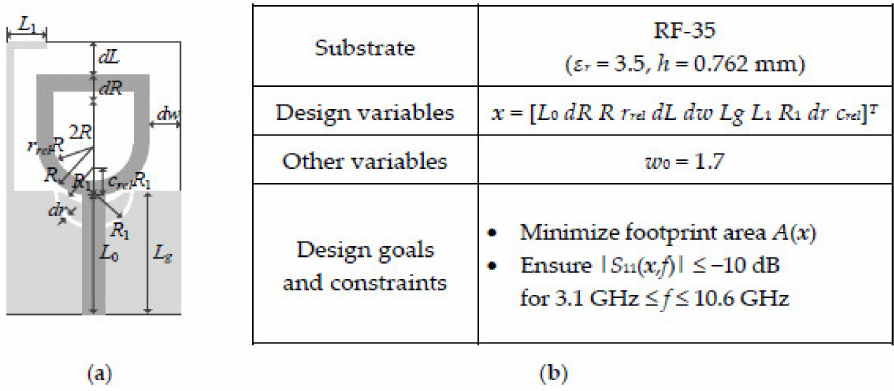
Figure 3. Ultrawideband antenna [55]: ( a ) geometry, ( b ) essential parameters.